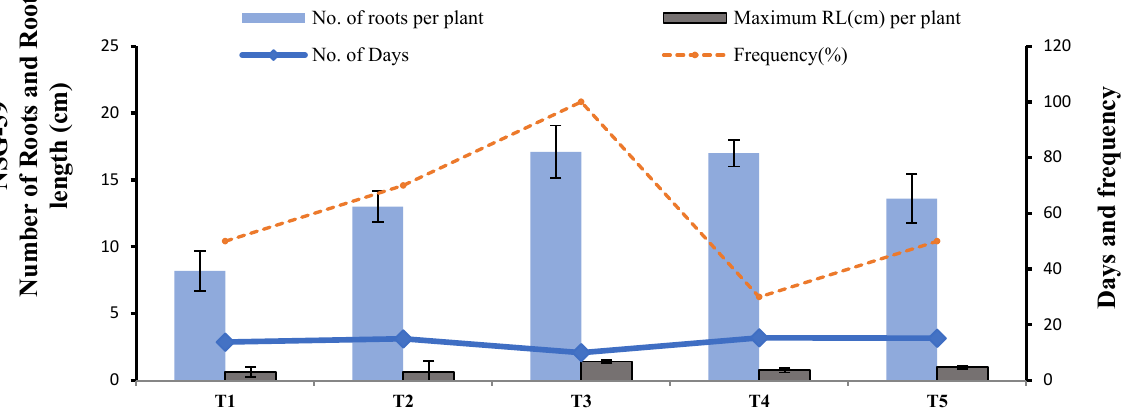
Figure 14. Effect of different media compositions on root induction in terms of root length (cm), number of roots, rooting frequency and number of days in CP-77400.